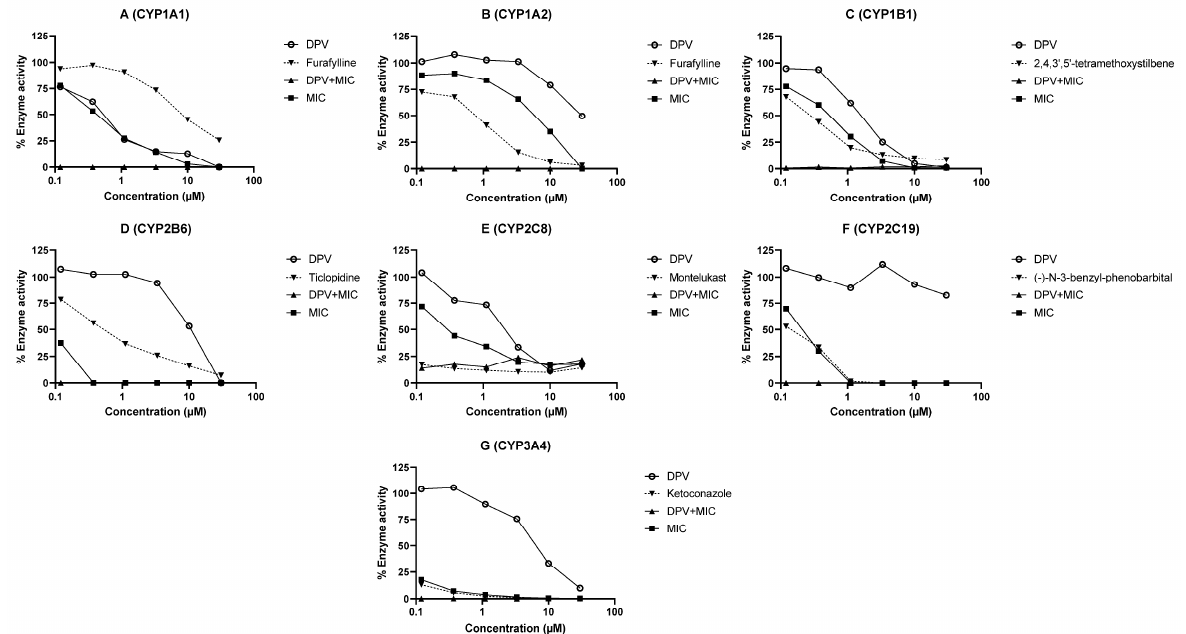
Figure 2. The CYP inhibition profiles of DPV, MIC and the combination of DPV and MIC determined using an individual probe substrate. Each test compound/inhibitor was incubated in a separate experiment using HLM or recombinant CYP with a substrate. Inhibition profiles of ( A ) CYP1A1 catalyzed phenacetin-O-deethylation, ( B ) CYP1A2 catalyzed phenacetin-O-deethylation, ( C ) CYP1B1 catalyzed 7-ethoxyresorufin O-deethylation, ( D ) CYP2B6 catalyzed bupropion hydroxylation, ( E ) CYP2C8 catalyzed amodiaquine N-deethylation, ( F ) CYP2C19 catalyzed S-mephenytoin 4′-hydroxylation and ( G ) CYP3A4 catalyzed midazolam 1′-hydroxylation. The enzyme activity is expressed as % remaining activity compared with negative control (without inhibitor). Data are shown as the mean of two biological replicates. Table 2. The IC 50 values of positive inhibitors, DPV, MIC and the combination of DPV and MIC for the inhibition of CYP and UGT enzymes using a single substrate approach. The in vivo inhibition potential was predicted for DPV and MIC from the IC 50 values. Data are presented as the mean of two biological replicates. IC50 ( µ M)